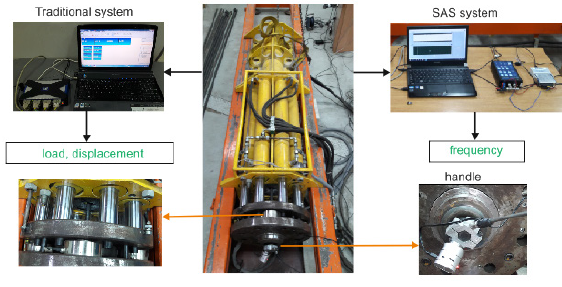
Figure 8: Measurement sensors of the traditional system and the